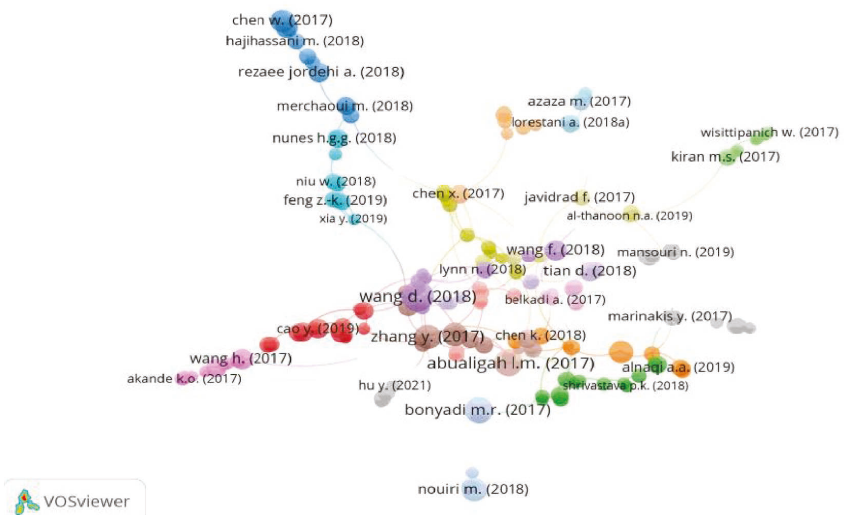
Figure 13: Network visualization map of the co-citations among top published/cited documents on PSOA